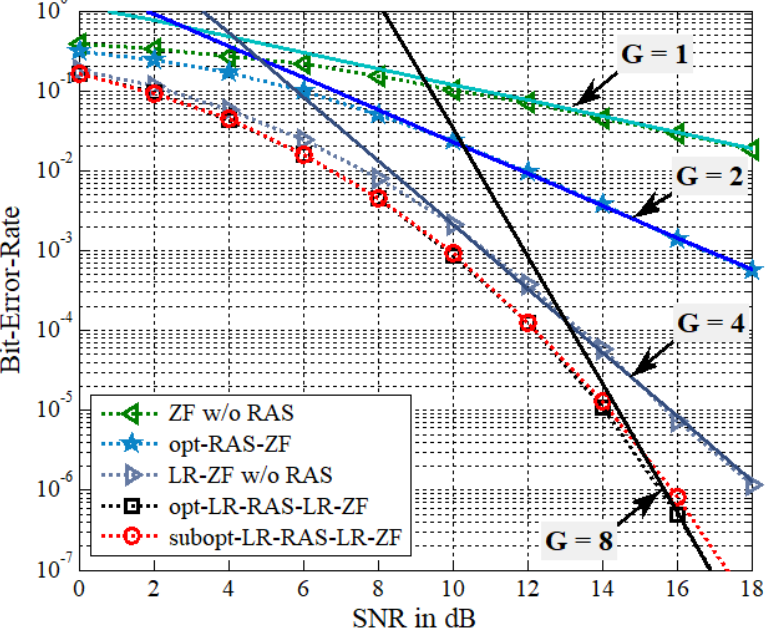
N  , 5 N  , and QPSK. T R